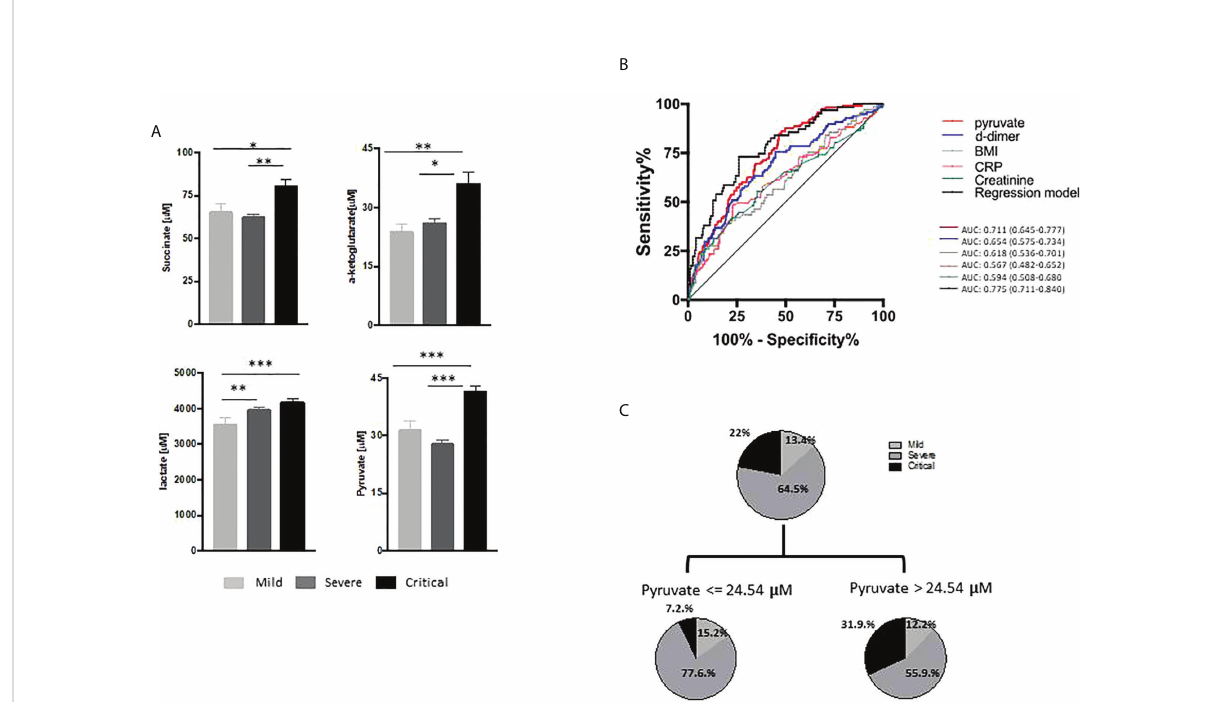
FIGURE 3 Energy-related metabolites in the validation cohort. (A) Serum levels (µM) of succinate, lactate, pyruvate and a -ketoglutarate determined by fl uorimetric assay in patients with mild (n=65), severe (n=218) and critical (n=115) COVID-19 disease. Statistical signi fi cance was estimated using the Kruskal-Wallis test and Dunn ’ s multiple comparisons test. (B) Receiver operating characteristic curves predicting COVID-19 severity included the parameters of the regression model (Table 3). (C) Regression tree (CART) analysis including all the previously selected variables as predictors of COVID-19 severity. The results were considered signi fi cant at *P<0.05; **P<0.01;